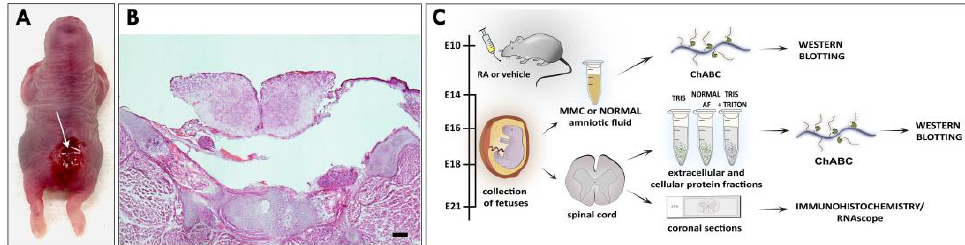
Figure 1. ( A ) Representative external view of RA-induced MMC defect in the lumbar region of a fetal rat at E21. Arrow indicates the beginning of the exposed spinal cord. ( B ) Representative H&E-stained cross section from the MMC defect in a fetal rat at E21 demonstrating a malformed spinal cord and failed development of overlying structures. Scale bar indicates 200 µm. ( C ) Overview of the experimental strategy.